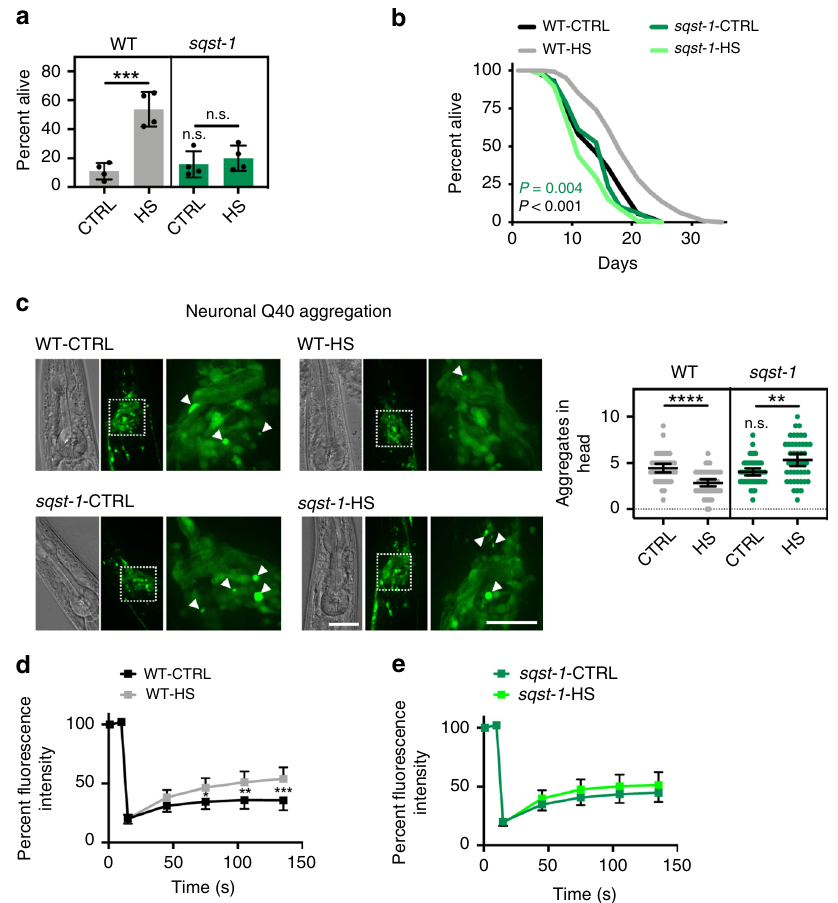
Fig. 2 sqst-1 is required for the organismal bene fi ts of a hormetic heat shock (HS). a Survival of WT (N2) and sqst-1(ok2892) ( sqst-1 ) animals subjected to HS on day 1 of adulthood, and then incubated for 7 h at 36 °C on day 3 of adulthood ( n = 4 plates). Error bars indicate SD, ns: P > 0.8, *** P < 0.001 by two- way ANOVA with Tukey ’ s multiple comparisons test. See Supplementary Table 1 for experimental details and additional repeats. b Lifespan analysis of WT and sqst-1(ok2892) ( sqst-1 ) animals at 20 °C subjected to 1h HS at 36 °C on day 1 of adulthood. WT-CTRL animals ( N = 126) compared with WT-HS animals ( N = 110): P < 0.0001; sqst-1 -CTRL animals ( N = 128) ( P = 0.3 to WT) compared with sqst-1 -HS animals ( N = 115): P = 0.004, by log-rank test. See Supplementary Table 2 for experimental details and additional repeats. c Neuronal PolyQ (rgef-1p::Q40::yfp) aggregates detected on day 4 of adulthood in WT and sqst-1(ok2892) ( sqst-1 ) animals maintained under control conditions (20 °C, CTRL) or subjected to HS (1 h at 36 °C) on day 1 of adulthood (HS). Scale bar 20 μ m. The number of neuronal PolyQ aggregates were quanti fi ed from three independent experiments in WT-CTRL, N = 43; WT-HS, N = 50; sqst-1 -CTRL, N = 48, sqst-1 -HS, N = 45 animals. Error bars indicate 95% CI. ns: P > 0.6, ** P < 0.01, **** P < 0.0001, by two-way ANOVA with Tukey ’ s multiple comparisons test. Scale bar 20 and 10 μ m for close-up. d , e FRAP measurements of neuronal PolyQ (rgef-1p::Q40::yfp) aggregates on day 8 of adulthood in WT ( e ) and sqst-1(ok2892) ( sqst-1 ) ( f ) animals maintained under control conditions (20 °C, CTRL) or subjected to HS (1 h at 36 °C) on day 1 of adulthood (HS). The fl uorescence signal was bleached after 20 s and fl uorescence recovery was measured for 2 min. The average % of fl uorescence intensity was quanti fi ed from three independent experiments in WT-CTRL, N = 32; WT-HS, N = 30; sqst-1 -CTRL, N = 32, sqst-1 -HS, N = 31 animals. Error bars indicate 95% CI. ** P < 0.05, ** P < 0.01, *** P < 0.001, by two-way ANOVA with Sidak ’ s multiple comparisons test. P > 0.05 for all timepoints when comparing WT-CTRL and sqst-1 -CTRL by two-way ANOVA with Sidak ’ s multiple comparisons test. Source data are provided in the Source Data fi